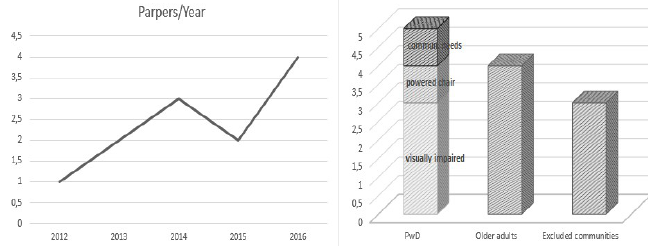
Fig. 3. TOCHI papers per year and issues